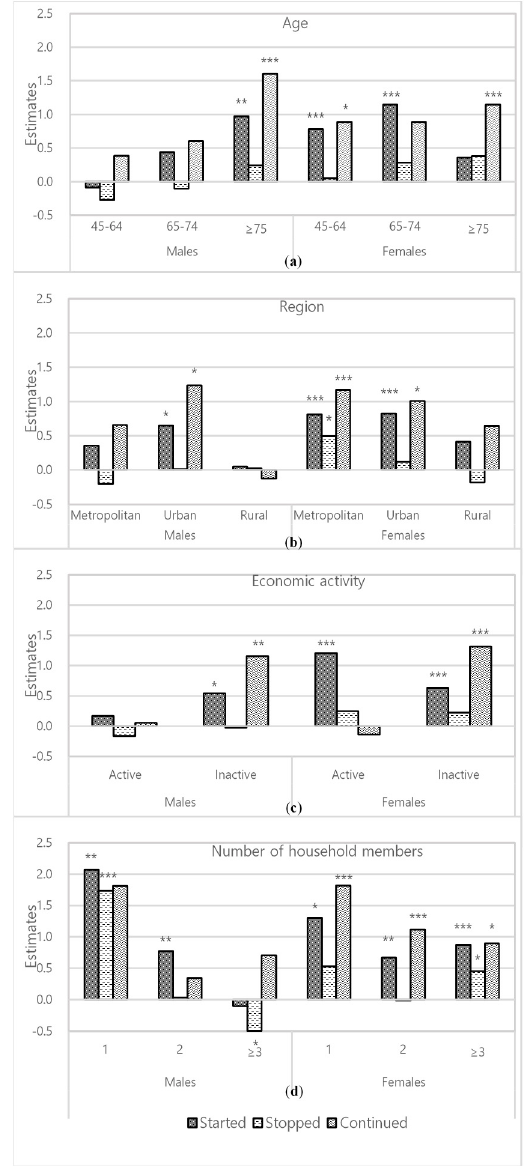
Figure 1. Results of subgroup analysis stratified by ( a ) age, ( b ) region, ( c ) current economic activity, and ( d ) number of household members. Each set of subgroup analysis was adjusted for other covariates (age, region, educational level, economic activity, household income, marital status, health insurance type, smoking, current alcohol drinking, regular physical activity, number of chronic diseases, and social activity). * p value ≤ 0.05; ** p value ≤ 0.01, *** p value ≤ 0.001.